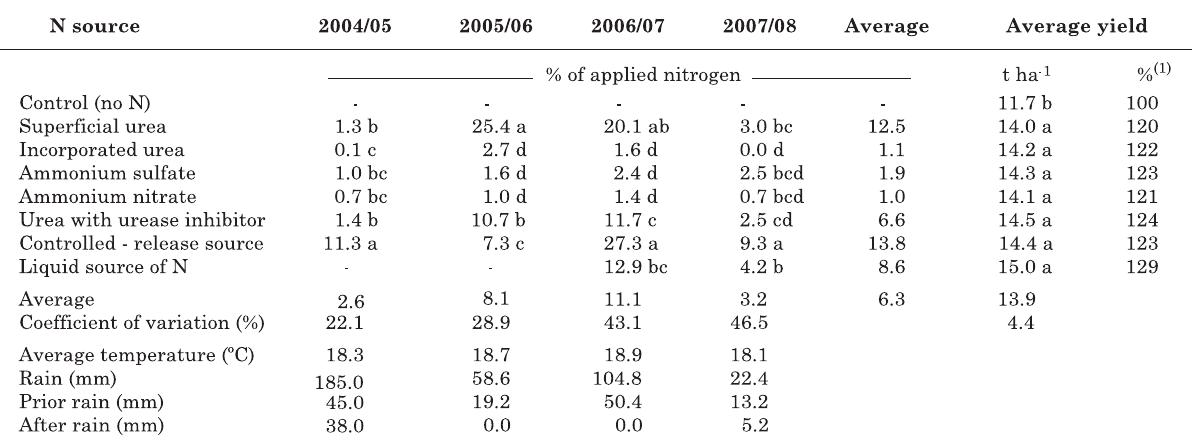
Table 2. Cumulative ammonia loss (N-NH ), average corn yield, relative grain yield, and average temperature 3 and volume of precipitation in November and in the first five days prior to and after